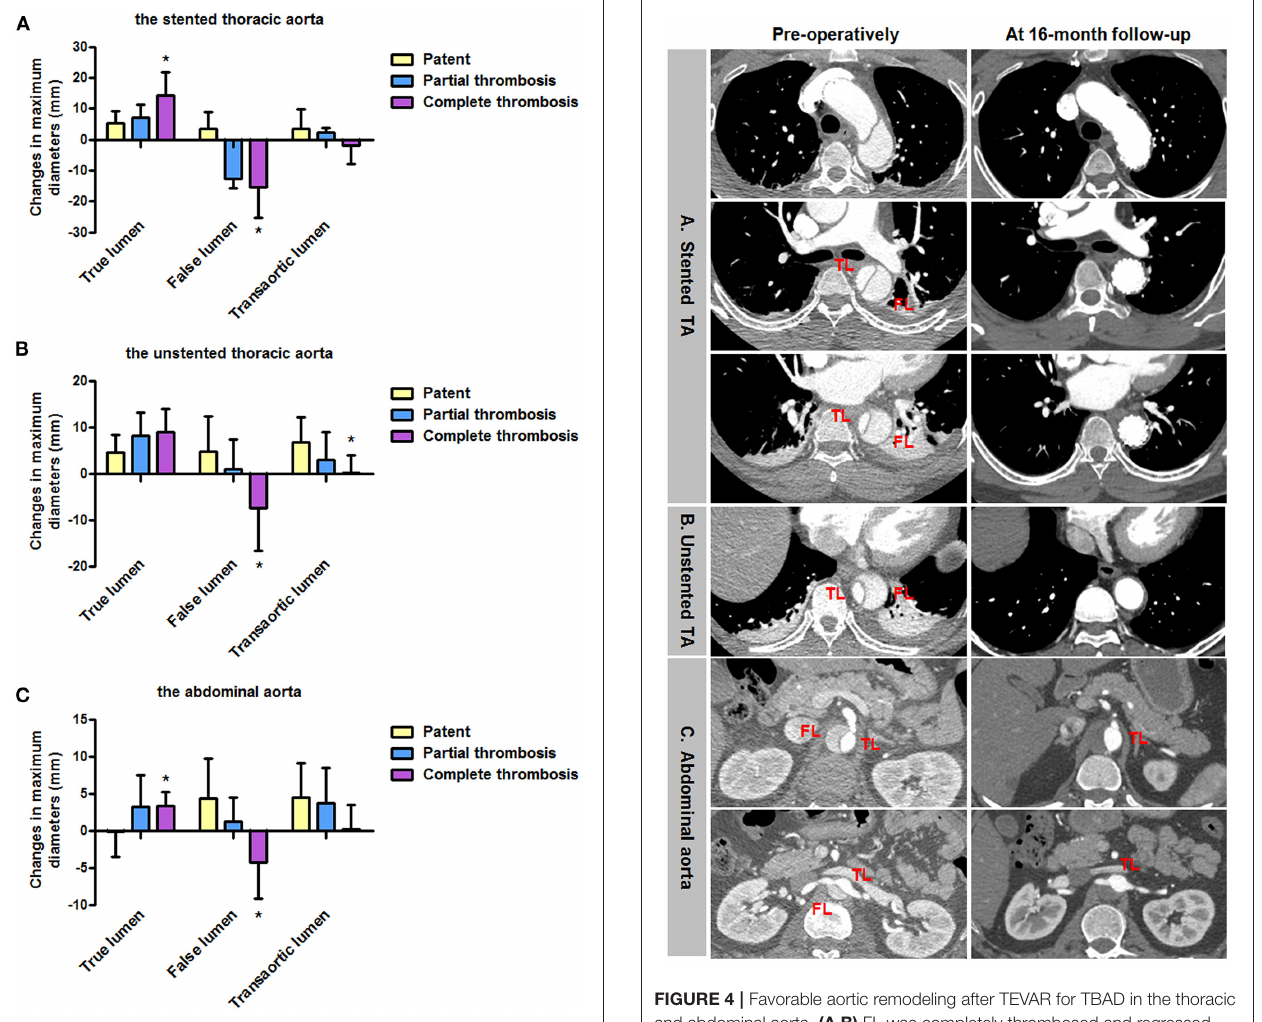
FIGURE 3 | Changes in lumen diameters from a pre-operative measurement according to the FL status during follow-up. (A) Changes in TL and FL diameters on the stented thoracic aorta were more in patients with completely thrombosed FL than in patients with patent or partially thrombosed FL. (B) Compared with patients with patent or partially thrombosed FL, patients with completely thrombosed FL showed more obvious changes in FL and transaortic diameters on the unstented thoracic aorta. (C) Abdominal aorta over time showed more changes in TL and FL diameters in patients with completely thrombosed FL than in patients with patent or partially thrombosed FL. FL, false lumen; TL, true lumen. * P < 0.05 versus partial thrombosis or patent.